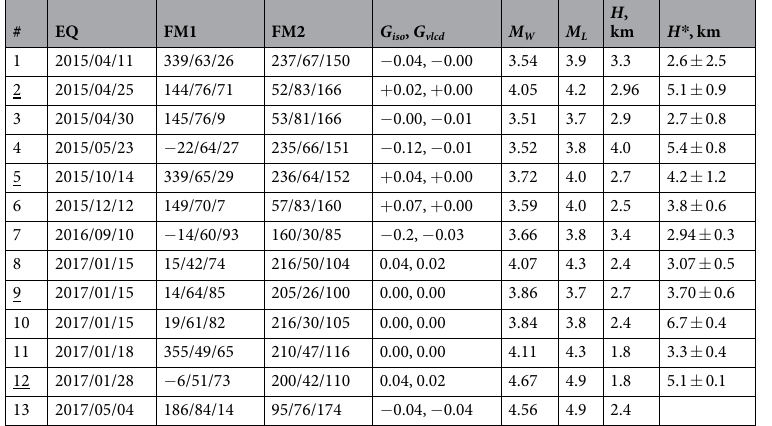
Table 1. Mechanism solution of the largest earthquakes ( M W > 3.5). Columns FM1 and FM2 show strike/ dip/rake of the two nodal planes. G iso , G vlcd are respectively the squared ratios of the scalar potency of the ISO and CLVD component to the total scalar potency, representing their relative strengths 23 . H and M W are central moment depth and moment magnitude of the best solution, respectively. For comparison, M L from the catalog and focal depth (H * ) and its standard error determined by the double differential relocation method are also shown. The focal depths are related to a mean surface level. A preferred velocity model (Supplementary Fig. 6 M-2) based on results of seismic ambient noise tomography of the Sichuan Basin was used for moment tensor inversion. From this table, we obtained an empirical relation between M L of the catalog and M W of the inversion: M W = M L − 0.22 (R 2 =